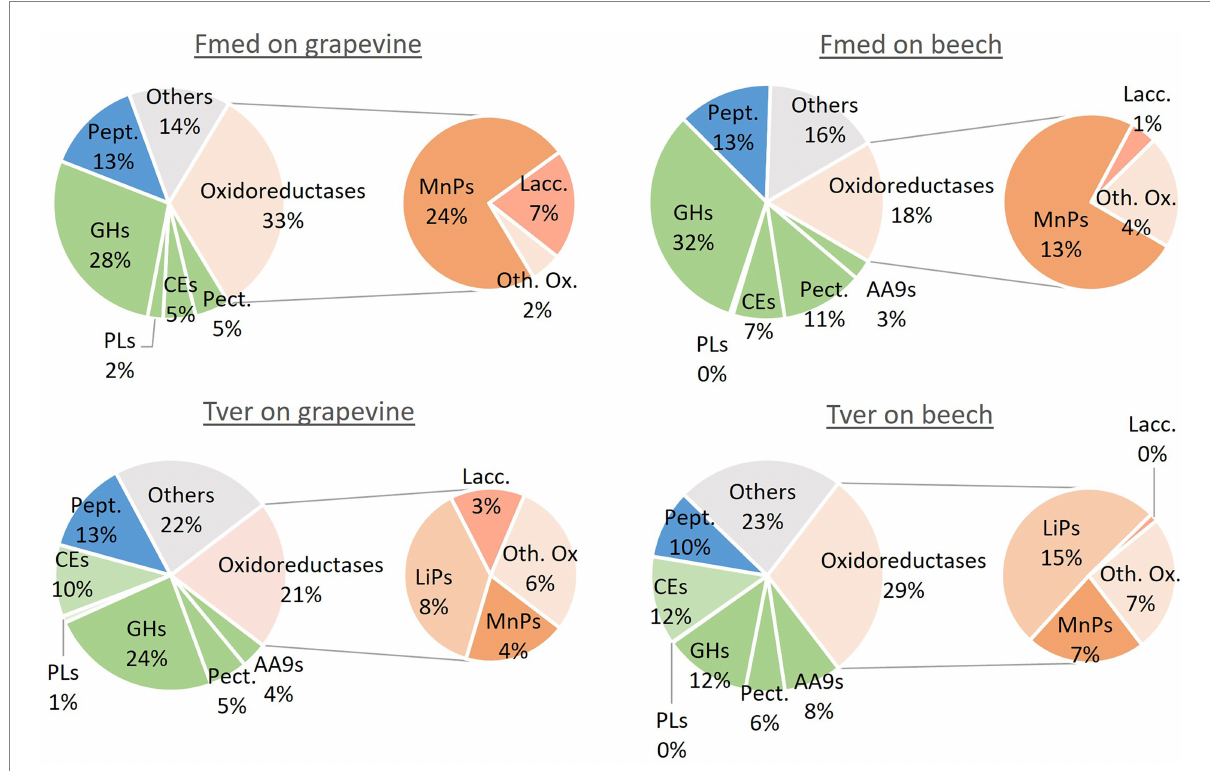
FIGURE 7 Relative abundance of main classes of proteins in Fmed and Tver secretome on grapevine and beech cultures. Pept.: peptidases, GHs: glycoside hydrolases, PLs: polysaccharides lyases, CEs: carbohydrate esterases, Pect.: pectinases, AA9 = auxiliary enzymes family 9 (or LPMOs), MnPs: manganese peroxidases, Lacc.: laccases LiPs: lignin peroxidases, Oth. Ox.: other oxidoreductases. Classification was performed according to JGI database and percentages are given according to PAI relative abundancies for all proteins with emPAI higher than ten in at least one of the culture